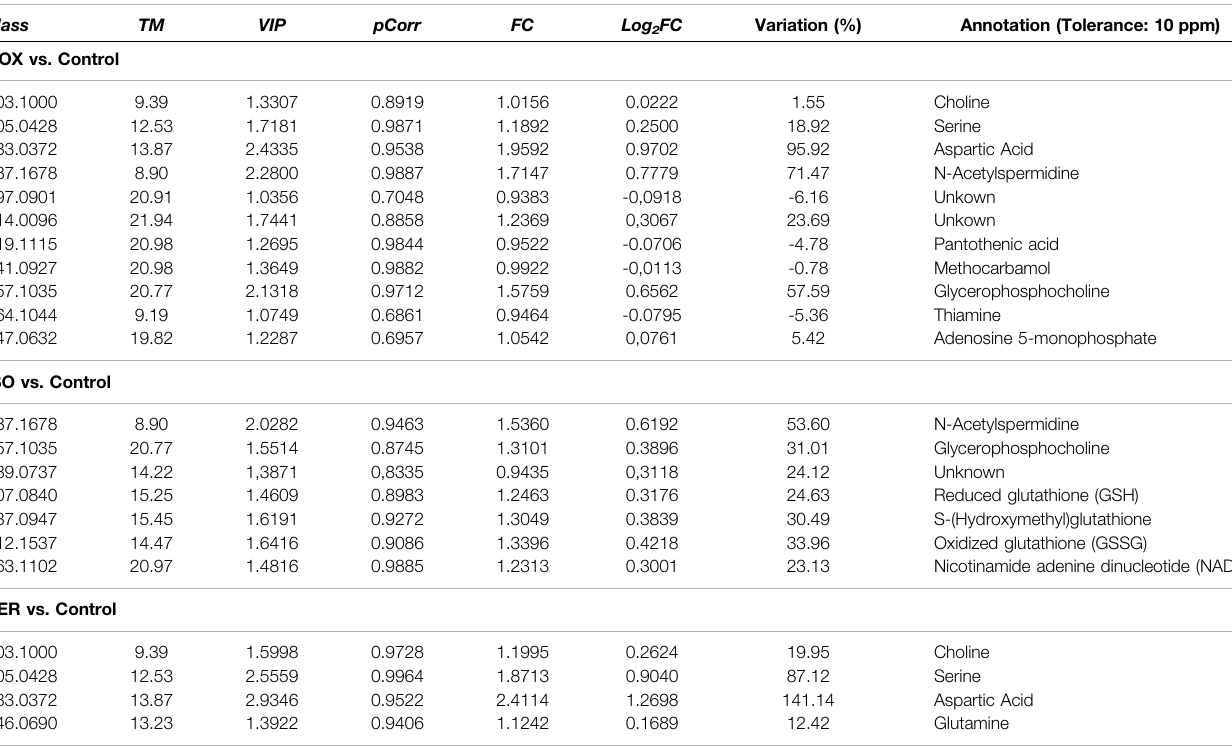
TABLE 1| Signi fi cantvariablesaccordingtoVIPandpCorrvaluesoftheOPLS-DAmodelobtainedfromH9c2cellsextractintheuntargetedmetabolomicevaluationbyCE- MS carried out in the positive ionization mode. FC = Fold Change. Mass TM VIP pCorr FC Log 2 FC Variation (%) Annotation (Tolerance: 10 ppm) DOX vs.